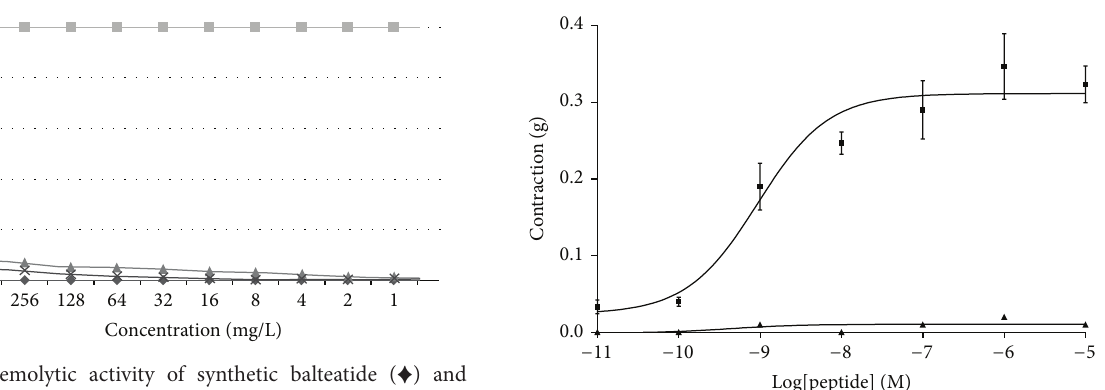
Figure 5: Haemolytic activity of synthetic balteatide ( Q ) and sauvatide ( × ), respectively. Positive ( ◼ ) and negative ( Q ) controls are included for reference. Figure 6: Dose-response curves of sauvatide ( ◼ ) and balteatide ( 󳵳 ) on rat bladder smooth muscle preparations. Each point represents the mean and standard error of six